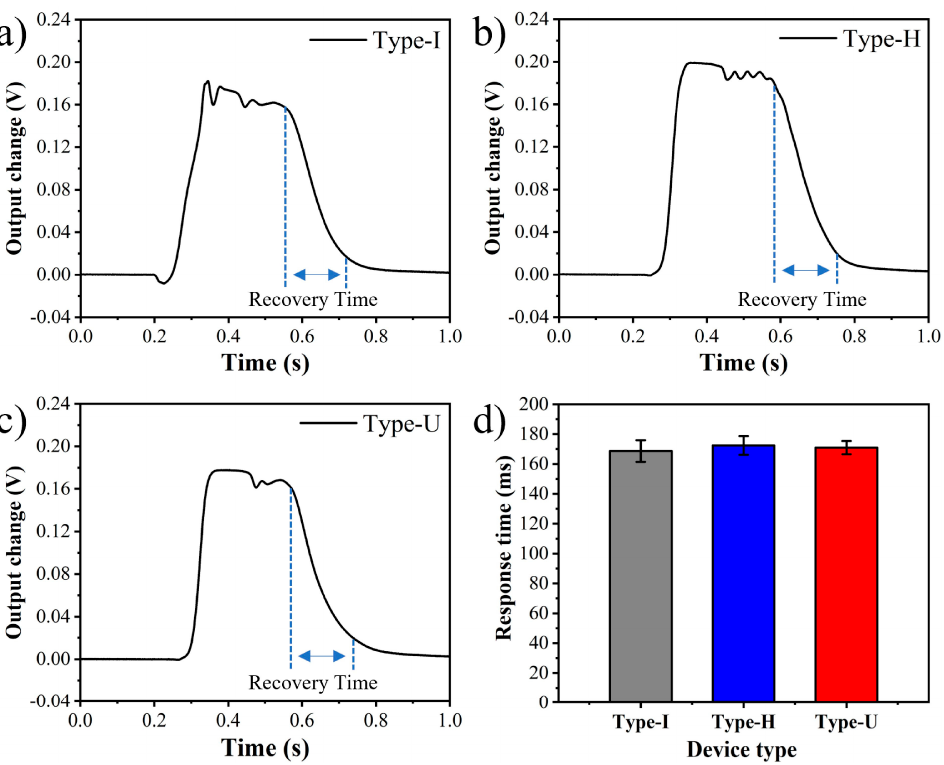
Figure 8. The response curve of ( a ) Type-I, ( b ) Type-H, ( c ) Type-U, ( d ) the recovery time of different types.